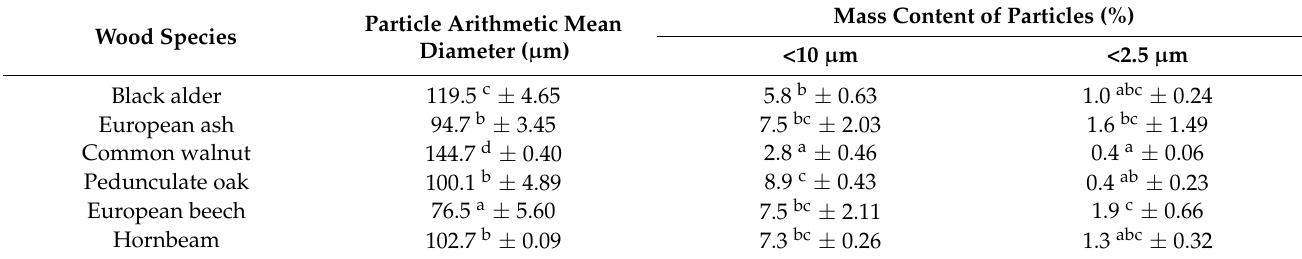
Table 2. Particle mean diameter and content of the finest dust fraction of the investigated hardwood species (identical superscripts a, b, c, denote no significant difference for p < 0.05).